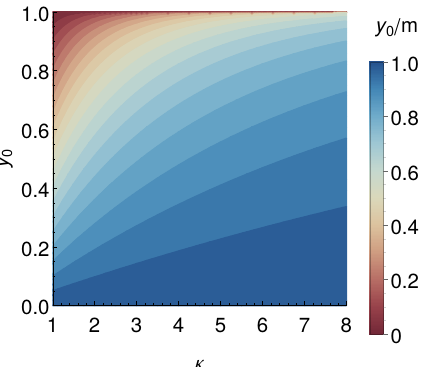
Figure 6. The ratio y 0 /m as a function of both y 0 and κ estimated from Eq.